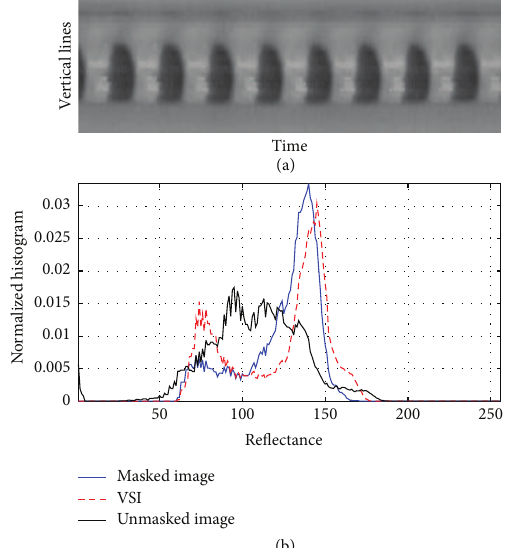
Figure 16: (a) Vertical slice image (VSI). (b) Reflectance histograms of unmasked, masked, and VSI images (reflectance is scaled by 255 for grayscale representation).